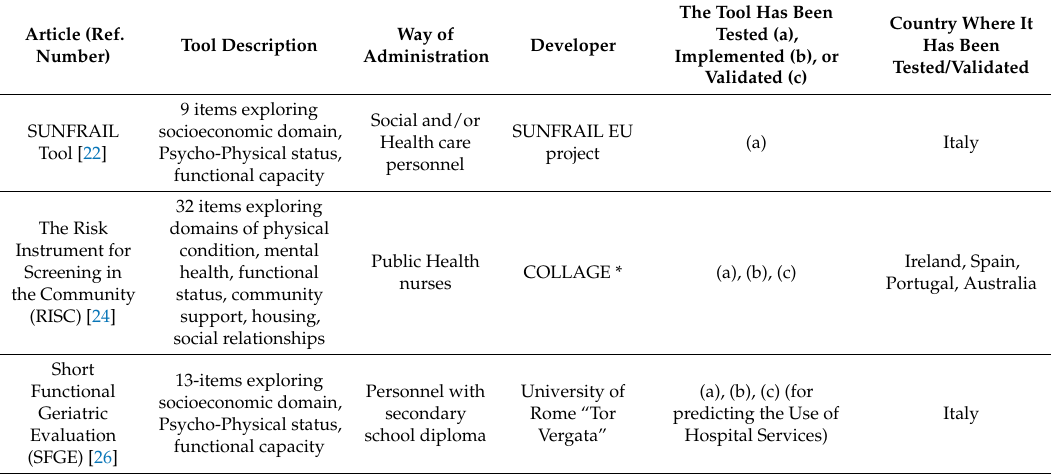
Table 1. Tools to assess Frailty or Quality of Life developed within the activities of the A3 group. Article (Ref.